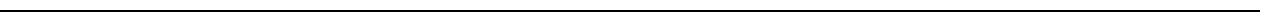
Fig. 6 HSF1-mediated PARP1 redistribution promotes DNA repair. a – c HeLa cells, in which endogenous HSF1 was replaced with each mutant, were treated with 0.5 μ M DOX, and then co-stained with γ H2AX and RAD51 antibodies, and with DAPI. Fluorescence images, obtained using scanning confocal microscopy, and merged images (DOX for 16 h) are shown ( a) . Scale bar, 5 μ m. Intensities of γ H2AX fl uorescence ( b ) and numbers of RAD51 foci ( c ) in 50 cells were estimated. Mean ± s.d. is shown. Asterisks indicate P < 0.01 by Student ’ s t -test. d Cells treated as in a were exposed to DOX for 2 h, and then recovered for 2 h. DNA damage in these cells was measured using a neutral comet assay (25 cells), and tail moment values are shown. Mean ± s.d. is shown. Asterisks indicate P < 0.01 by Student ’ s t -test. e Schematic structure of pDR-GFP reporter construct. SCE-1 region indicates an ampli fi ed region by ChIP-qPCR. f Accumulation of PARP1 and γ H2AX in the SCE-1 region. HeLa-DRGFP cells, in which HSF1 was replaced as in a , were transfected with an I- SceI expression vector, and analyzed by ChIP assay ( n = 3). Mean ± s.d. is shown. Asterisks indicate P < 0.01 by Student ’ s t -test. g Ef fi ciency of HR repair. Numbers of GFP-positive cells among 200 cells were counted, and the percentages of these cells are shown ( n = 3) (left). Mean ± s.d. is shown. Asterisks indicate P < 0.01 by Student ’ s t -test. HSF1 levels were examined by immunoblotting (right). h Schematic showing ampli fi ed regions, HSE and LUC, in the reporter constructs. The I-SceI cutting site is located upstream of the luciferase gene. The HSE and CRE elements are indicated. i Occupancy of HSF1 and PARP1 on the HSE and LUC regions during I-SceI treatment. The cells were transfected with pCBASce for 24 h, and ChIP-qPCR was performed. Some cells were treated with DOX for the last 8 h. Fold changes (FC) of PARP1 binding on the LUC region during I-SceI treatment are shown ( n = 3). Mean ± s.d. is shown. Asterisks indicate P < 0.01 by Student ’ s t